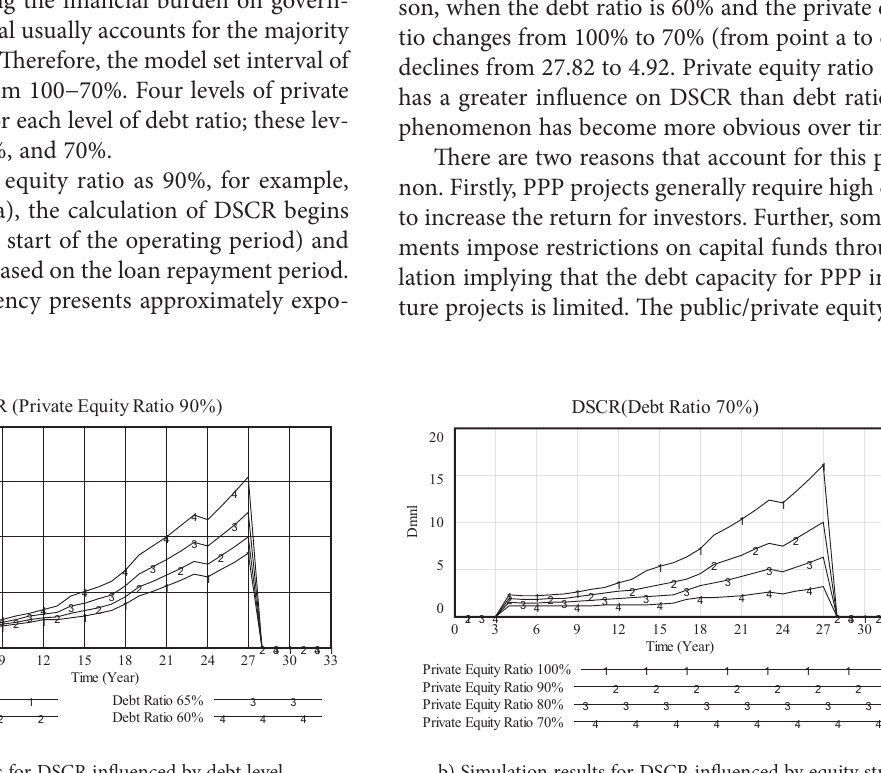
Figure 7. Simulation results for DSCR influenced by different financing strategies